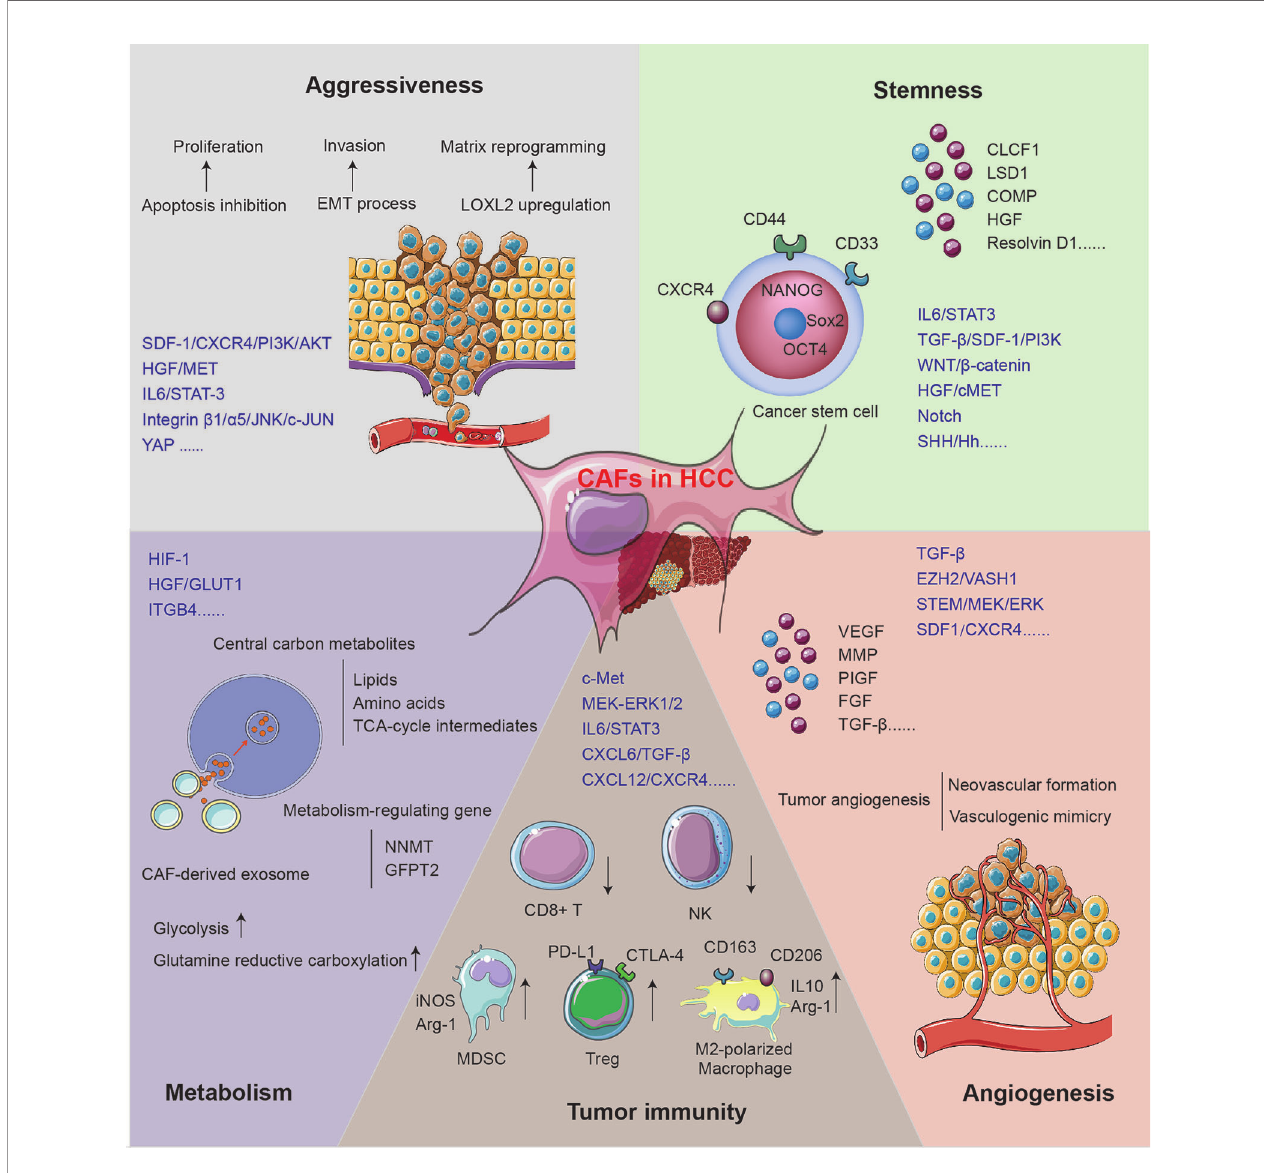
FIGURE 2 | The mechanisms for CAFs in supporting HCC